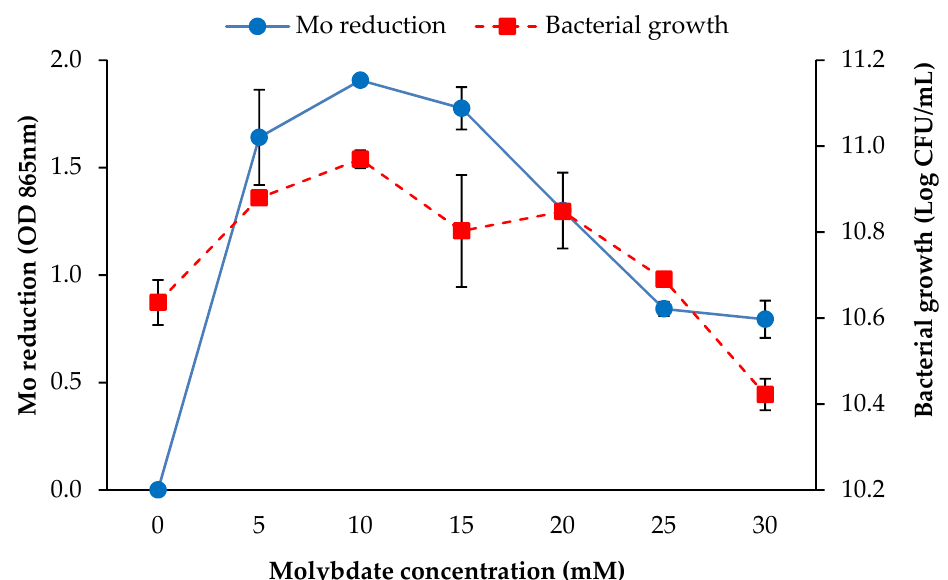
Figure 5. The effects of molybdate concentration on Mo reduction and growth activity of strain AQ5-05. The error bars represent the mean ± standard deviation for three replicates.